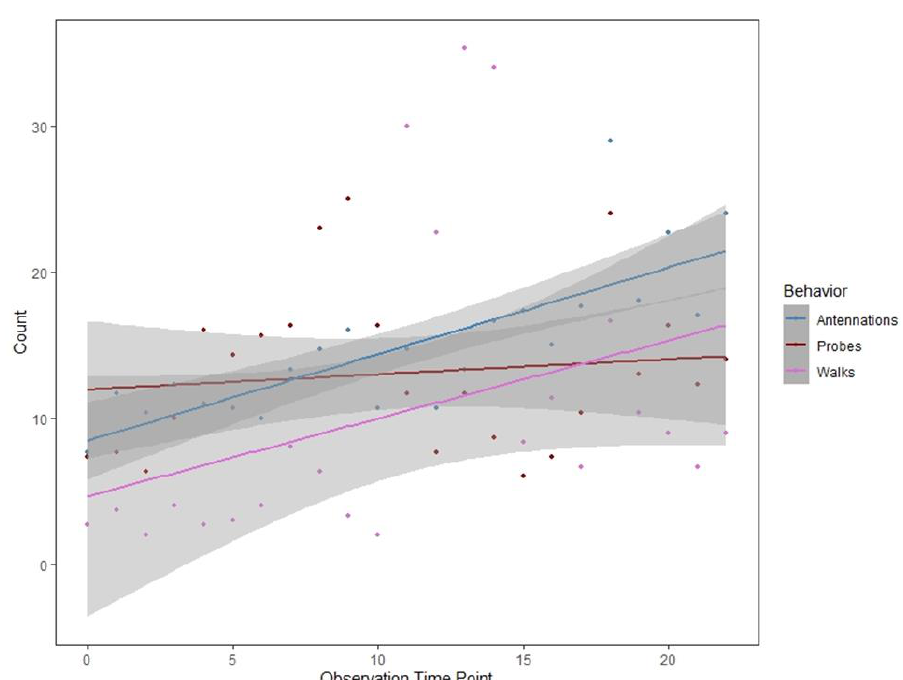
Figure 7. Regression of Aphytis melinus inspection and probing behavior on Rhizaspidiotus donacis hosts over a 3-day period. Shaded areas represent 95% confidence intervals. Parasitoids showed both immediate and sustained interest in hosts, with all three chambers producing a second gener- ation of adults.